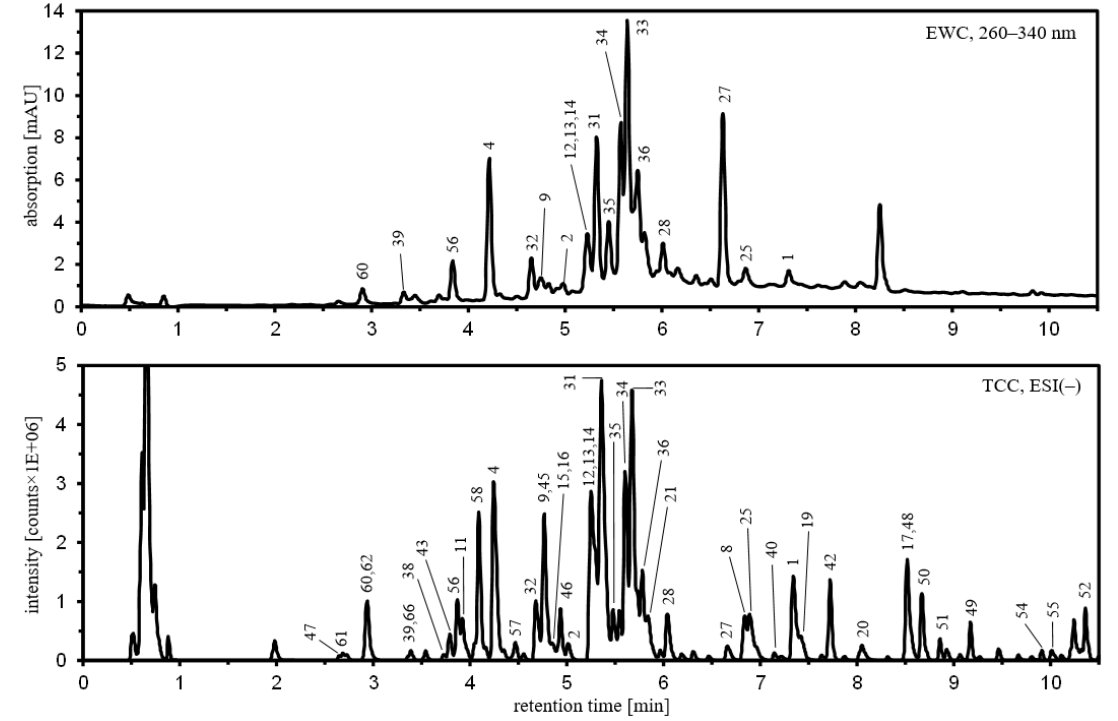
Figure 2. Representative chromatograms obtained from a hydroethanolic extract of a pooled leaf sample of the Konar Siah population using UHPLC/DAD/ESI-QTOFMS operated in negative ion mode. The upper panel shows an extracted wavelength chromatogram (EWC) from 260–340 nm, the lower panel a total compound chromatogram (TCC), which was reconstructed from raw data using the algorithm “Find Compounds by Molecular Feature” implemented in MassHunter Qualitative Data Analysis. For compound labelling, see Table 2. Further analytical data is detailed in Supplementary Table S1.